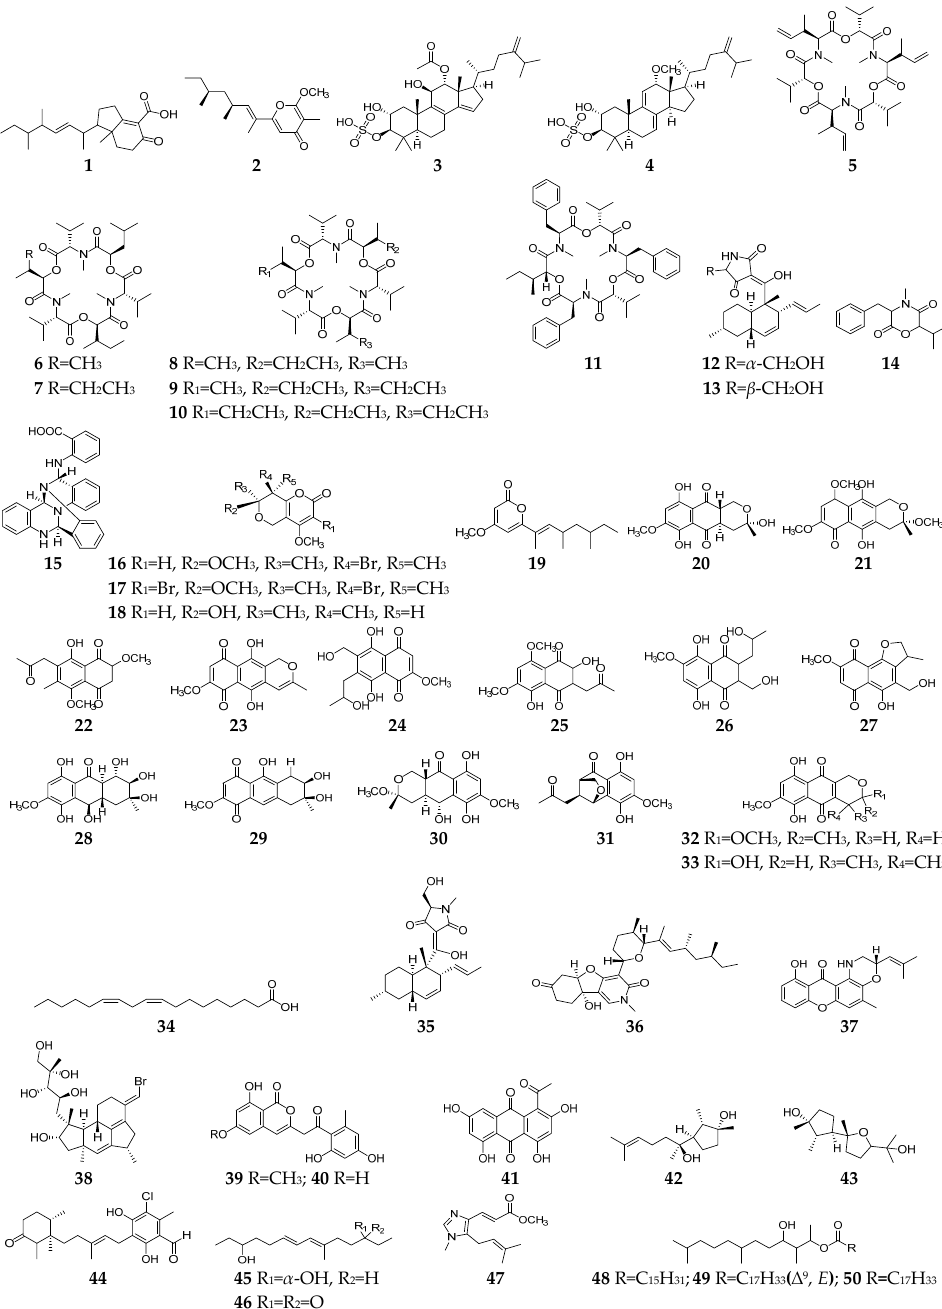
Figure 1. Fusarium -derived anti-Gram-positive bacterial SMs ( 1–50 ).